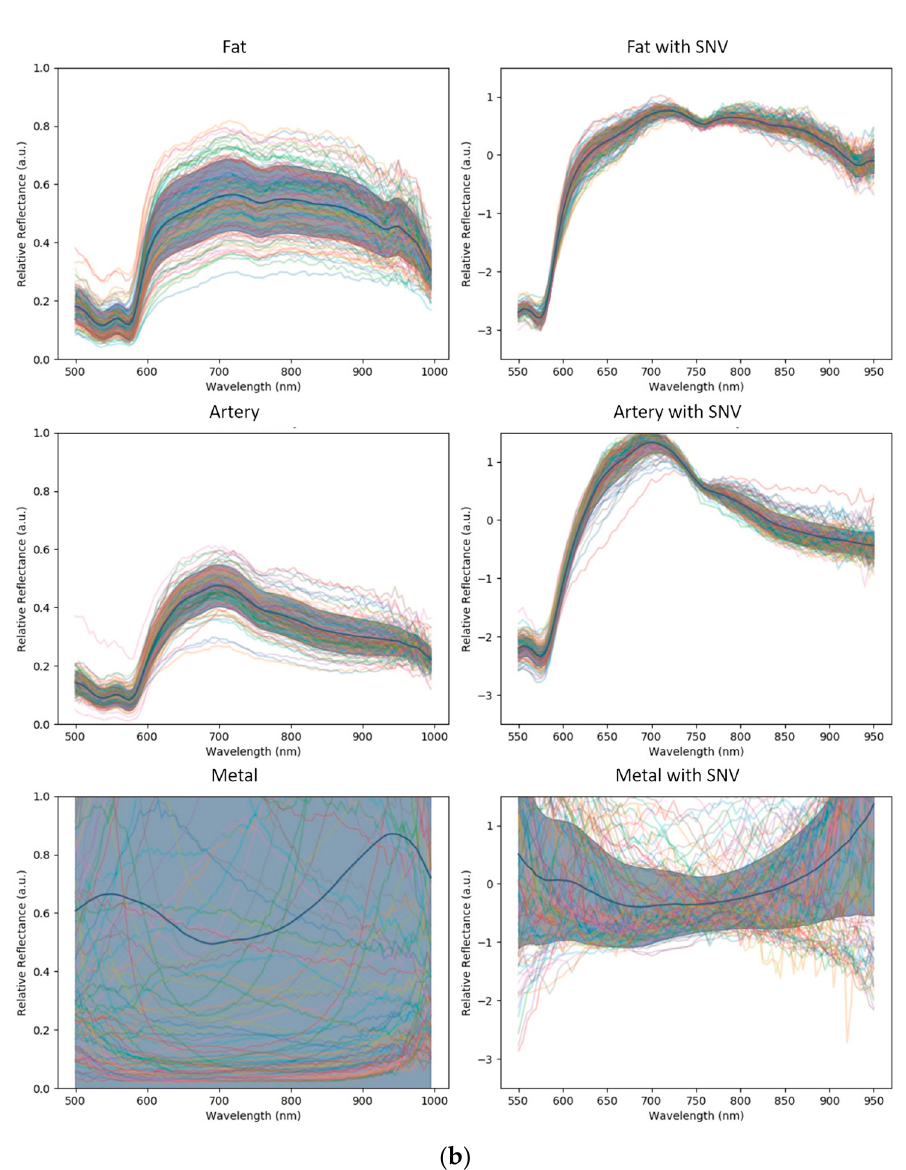
Figure 2. ( a ) Standard normal variate (SNV) within the classes: Spectral curve profiles of the tissue classes without and with SNV normalization. Relative absorption is plotted as a function of wavelength for each class. The mean spectral curve is shown as a black solid line, and the curve spread is shown with a gray band of one standard deviation from the mean curve. ( b ) Standard normal variate (SNV) within the classes: Spectral curve profiles of the tissue classes without and with SNV normalization. Relative absorption is plotted as a function of wavelength for each class. The mean spectral curve is shown as a black solid line, and the curve spread is shown with a gray band of one standard deviation from the mean curve. The metal class has a very large spectral distribution because of specular reflections, with a completely different profile to the tissue classes.